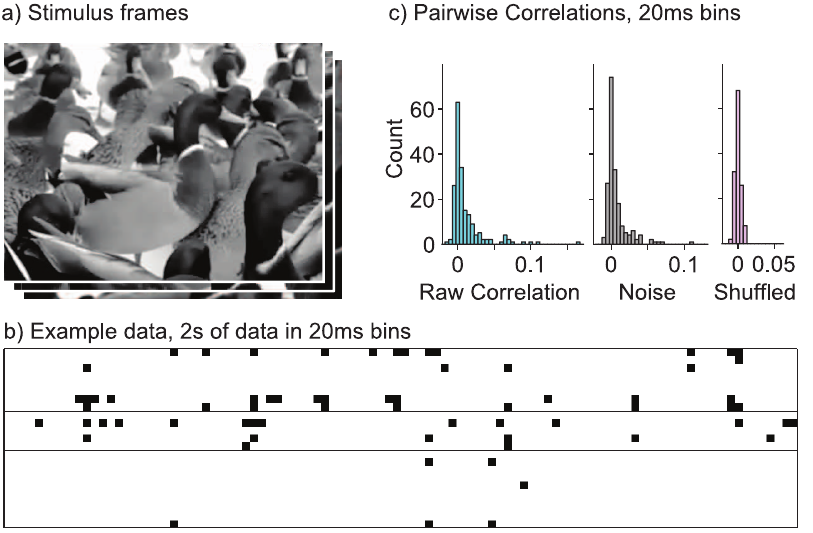
Figure 1. Laminar population recordings in response to natural movies. ( a ) Example of one of the natural movie stimuli, depicting ducks on a lawn, presented full-field at 150 frames per second. ( b ) Example data from 22 cells (session B4), binned in 20 ms windows, 2 s of data. Columns of this matrix form the training data for our algorithm. For the spatiotemporal version of the model, several adjacent columns are concatenated. ( c ) Pairwise correlations in the raw data, and noise correlations computed from 60 repetitions of a 30 s stimulus, binned at 20 ms. Both show small, positive correlations. Shuffling spikes for each of the cells shows that correlations expected due to shared firing rate modulations time-locked to the stimulus are much smaller.